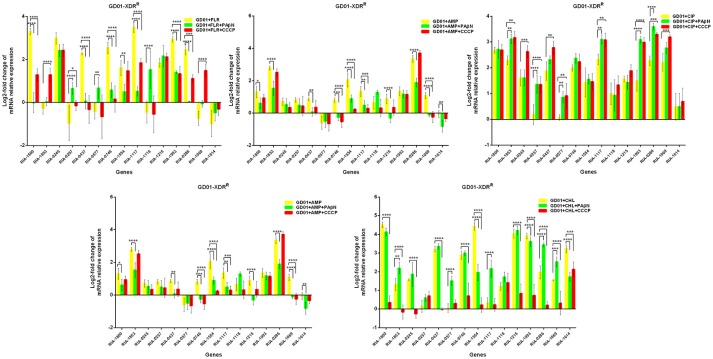
Quantification of the relative mRNA expression levels of a panel of EPGs in GD01 strains. Strains were grown in the presence of half MIC of each antibiotic; CCCP (5 μg/mL) and PAβN (40 μg/mL) showed no effects on the growth of R. anatipestifer isolates. The MICs of the antibiotics and EPIs were determined for each strain and are presented in Table 4. Change in the level of transcription of EPGs was measured as fold change normalized to recA gene expression and was subsequently calculated as log2-fold change that is relative to the untreated cell culture. Levels of significance were set as follows: *P < 0.05 was considered statistically significant, and **P < 0.01, ***P < 0.001, and ****P < 0.0001, were all considered highly significant.